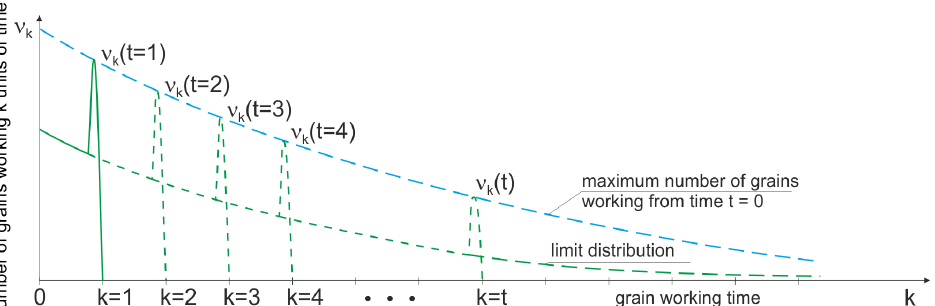
Figure 2. The distribution of the number of grains in successive moments t of the grinding